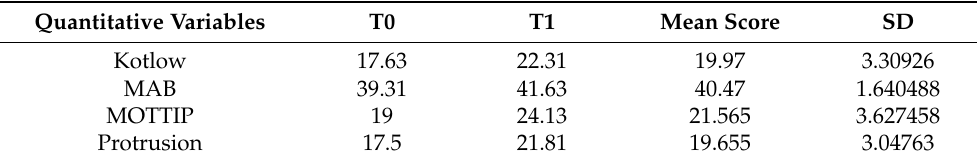
Table 9. Comparison of T0 and T1 of the CG in relation to the quantitative variables. Quantitative